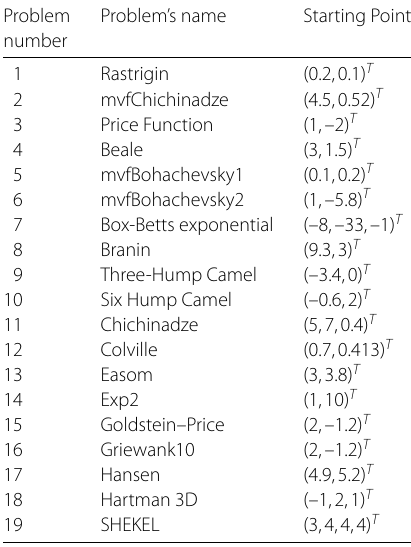
Table 6 Set of Test